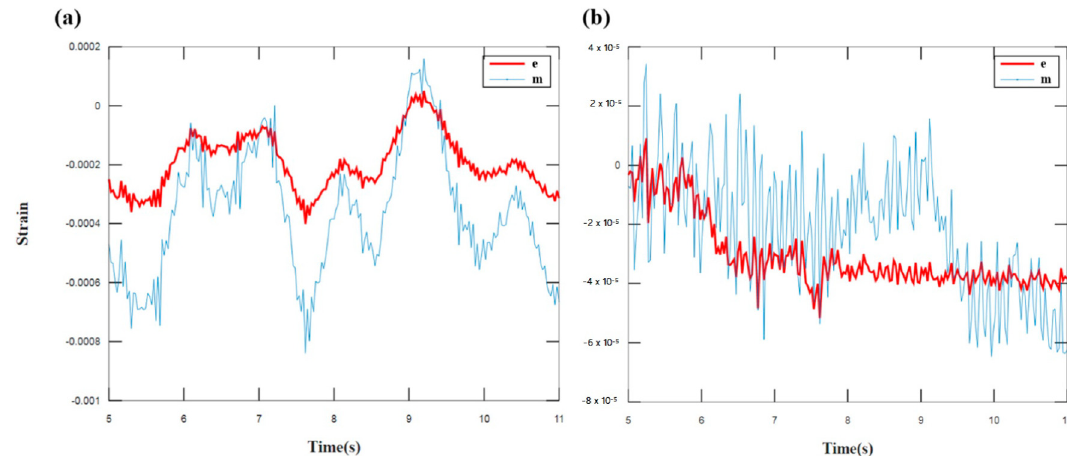
Figure 7. Simulation results of Case 3-1 at Location 1 under ( a ) wind loading and ( b ) wave loading; e and m denote expanded and measured strains, respectively. We eliminated the first 5 s of simulation results, which were calculated as the preloading step.